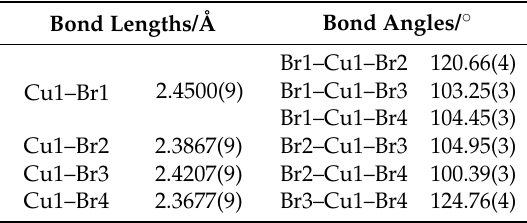
Figure 2. Molecular structure of (HexPh 3 P) 2 [CuBr 4 ] ( 8 ), hydrogen contacts are presented as fragmented lines. Table 5. Hydrogen bond geometry for (HexPh 3 P) 2 [CuBr 4 ] ( 8 ). Table 4. Selected bond lengths and bond angles for (HexPh 3 P) 2 [CuBr 4 ] ( 8